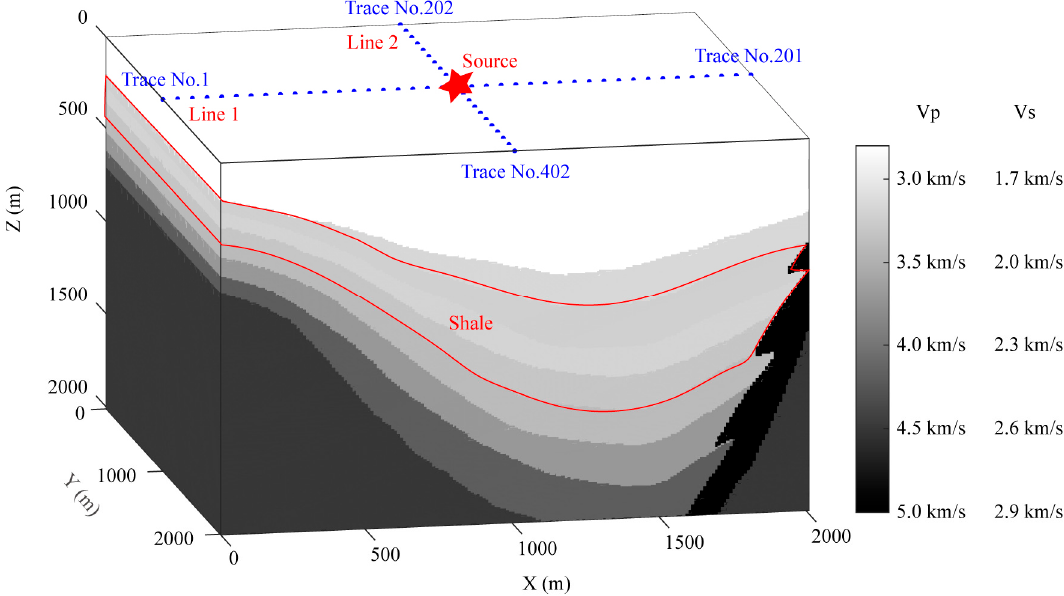
Figure 11. JY depression model, source, and observation system. The red star is the source; the blue dots are the detectors distributed on two survey lines (402 detectors in total, with 10 m spacing).